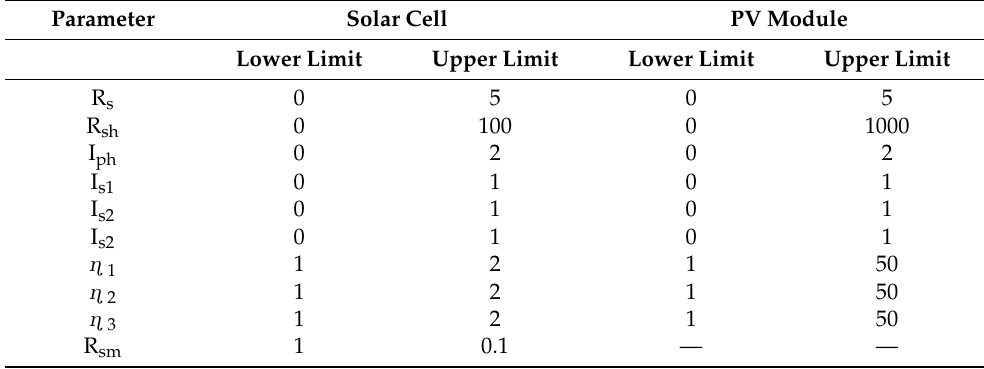
Table 1. Parameter lower and upper constraints.